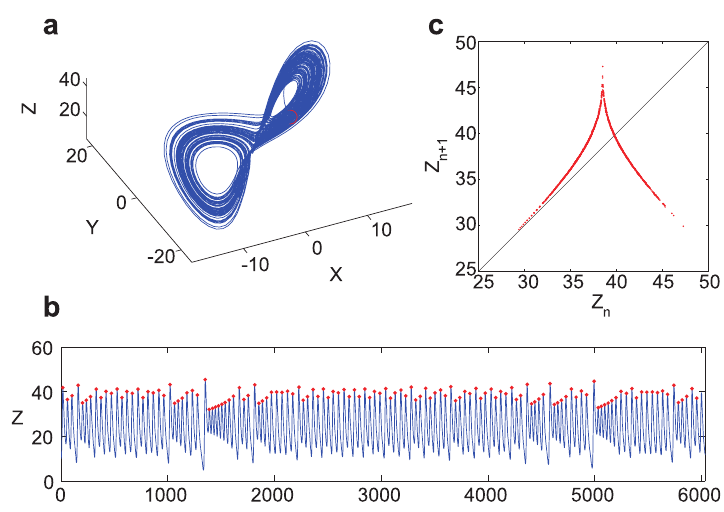
Figure 2. Lorenz attractor and Lorenz map. Parameters σ = 10, b = 8/3, r = 28, and x 0 = y 0 = z 0 = 10. ( a ) Lorenz attractor in three-dimensional space. ( b ) Time series of z ( t ) and peaks of z ( t ) are shown as red dots. ( c ) Lorenz map plotted as z n vs. z n + 1 .